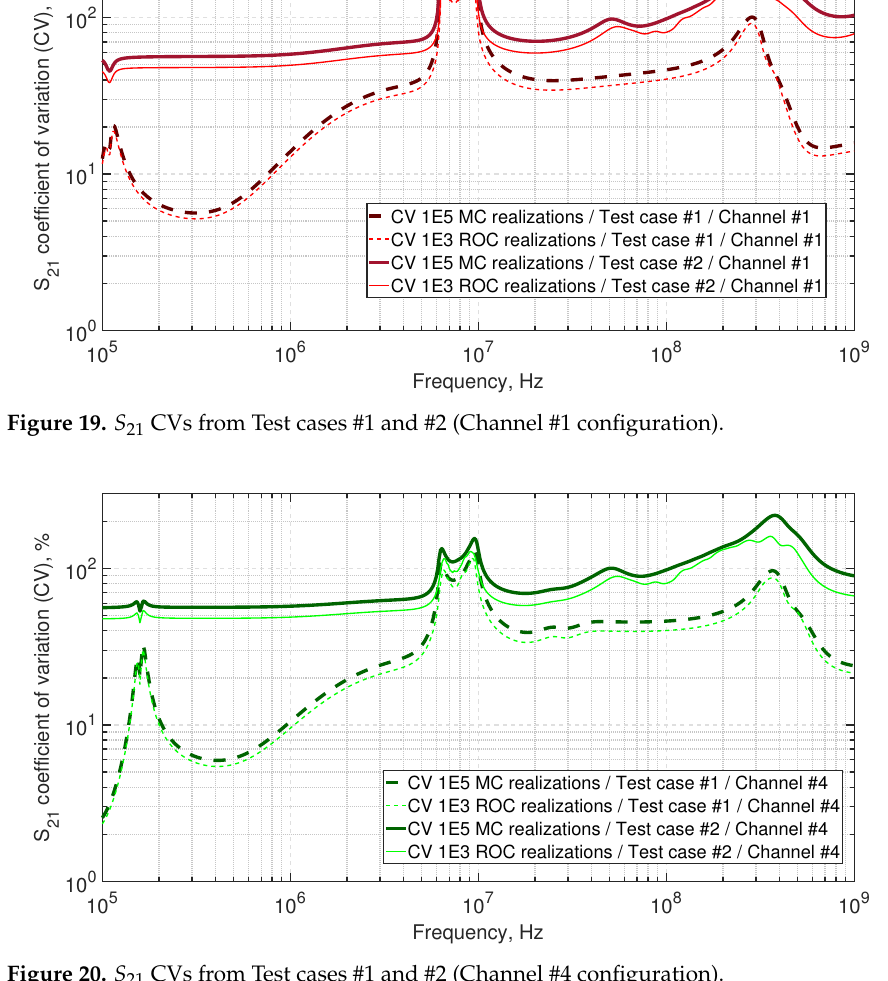
Figure 20. S 21 CVs from Test cases #1 and #2 (Channel #4